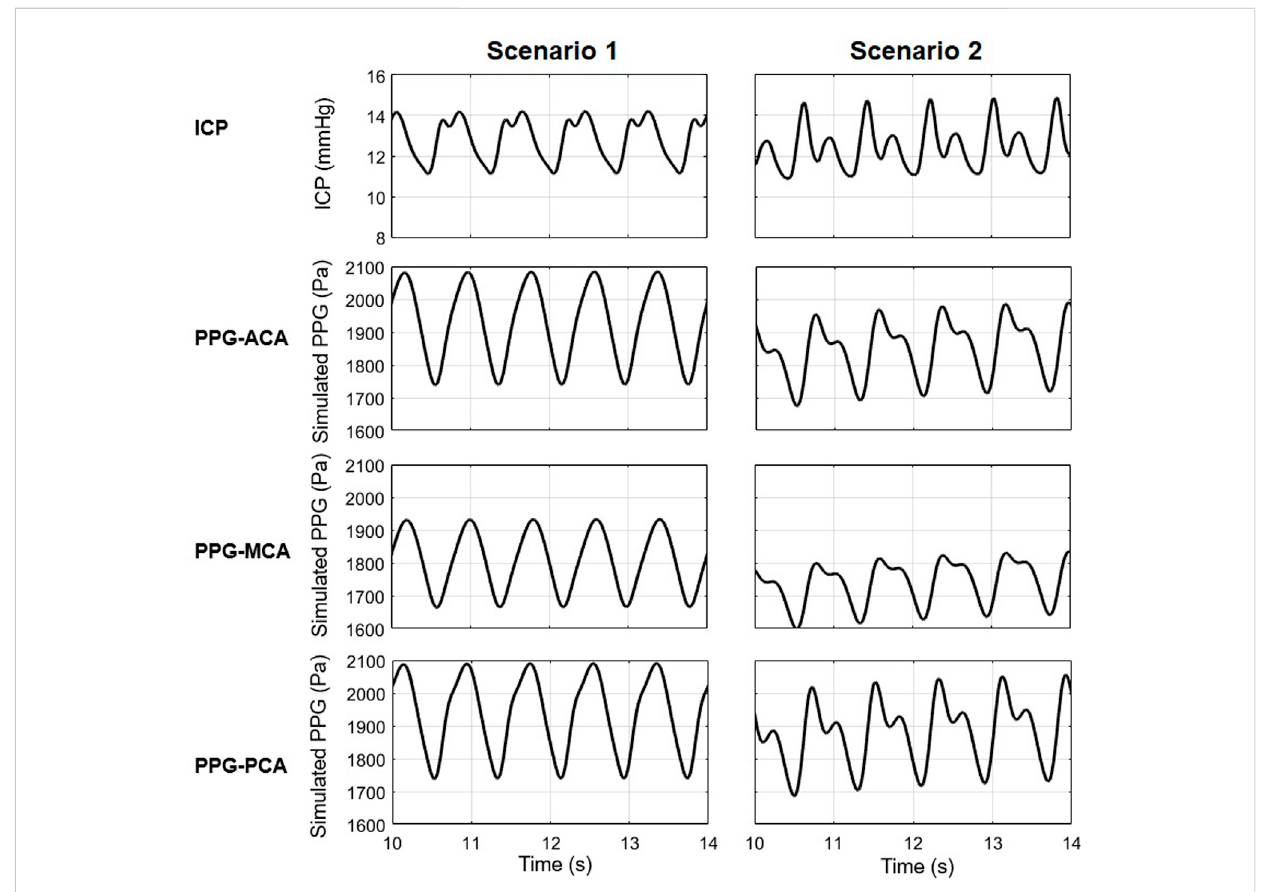
FIGURE 11 The ICP and PPG signals simulated in two scenarios with different values of the elements in cardiocerebral artery